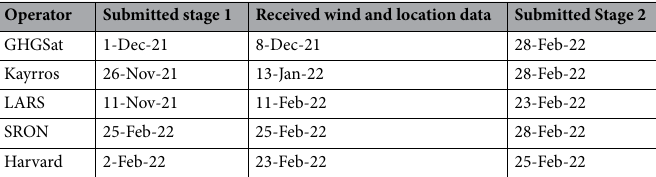
Table 2. Data submission timeline by stage for each